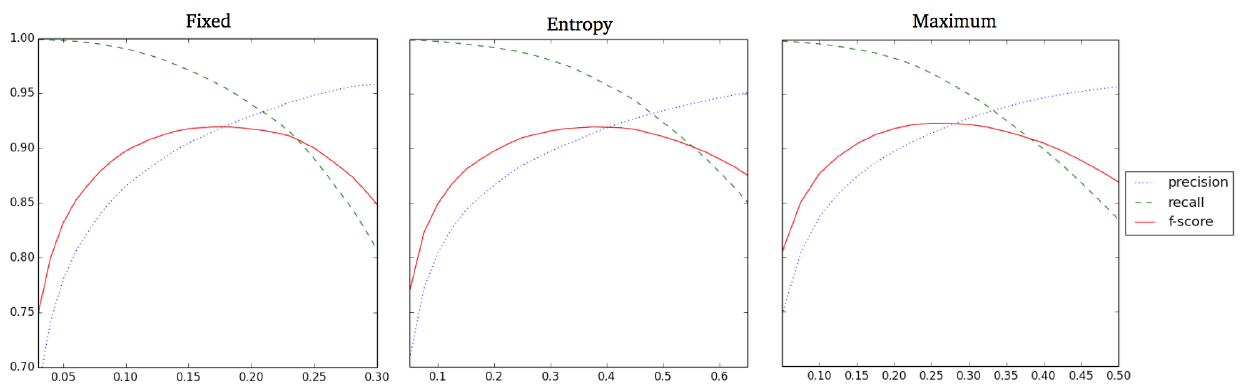
Figure A1. Precision, recall and f-score for different values of ρ and for different formulations of τ on the training set.